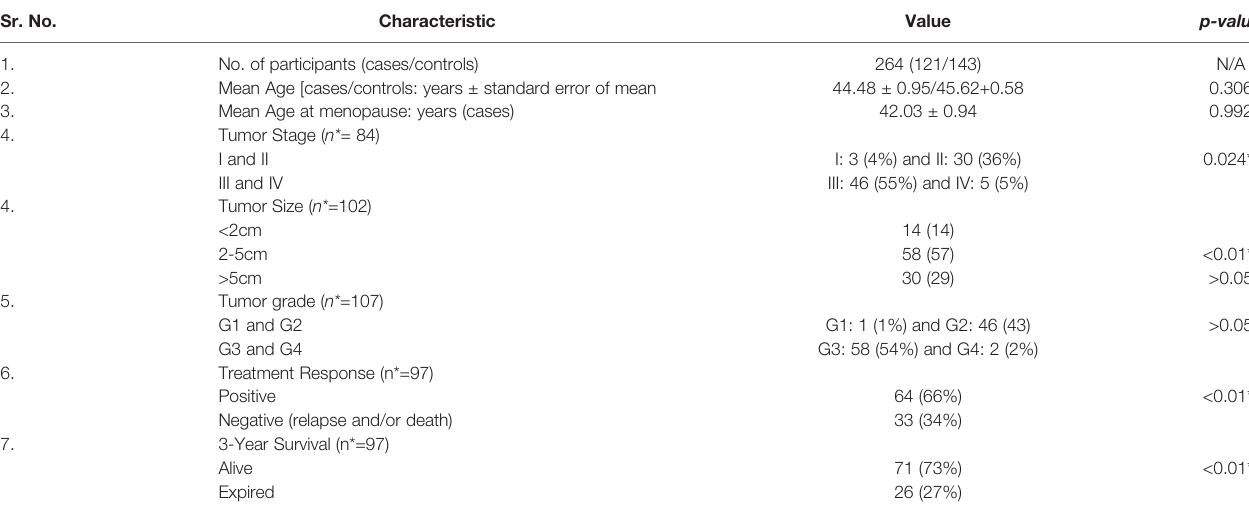
TABLE 1 | Participant information and clinico-pathological data of breast cancer patients. Sr.